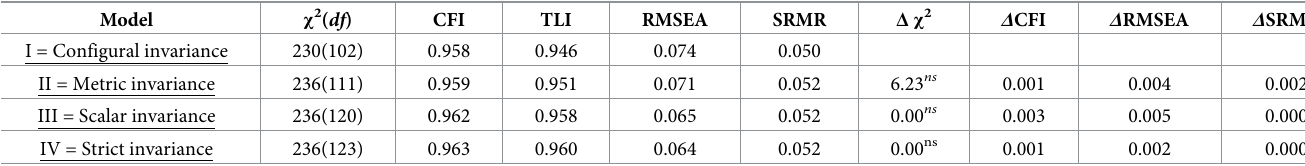
Table 3. Measurement invariance: Multi-group CFA fit indices (Study